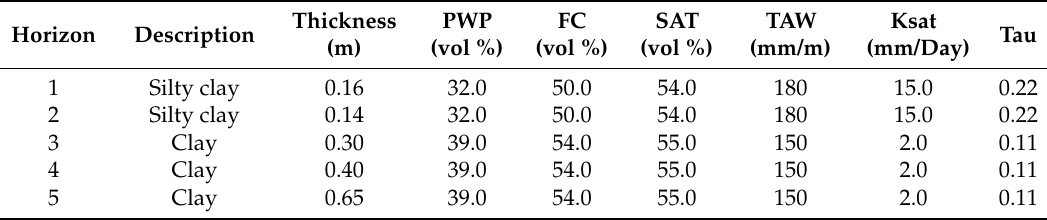
Table 1. Soil horizon profile